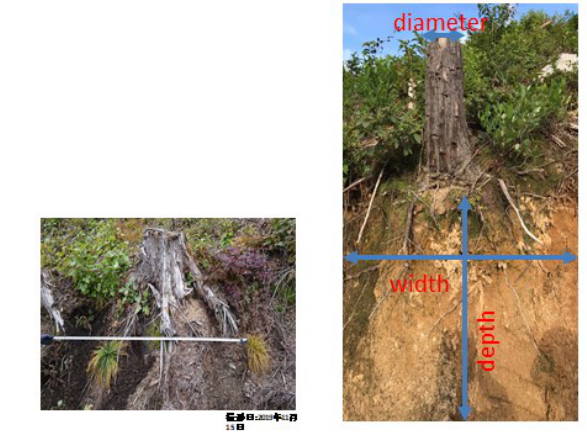
Figure 2 . Survey of root system development For the survey of all trees, a square sections with a size of 20m four corners of the square section are measured by GNSS, and position and diameter of the stump were measured.